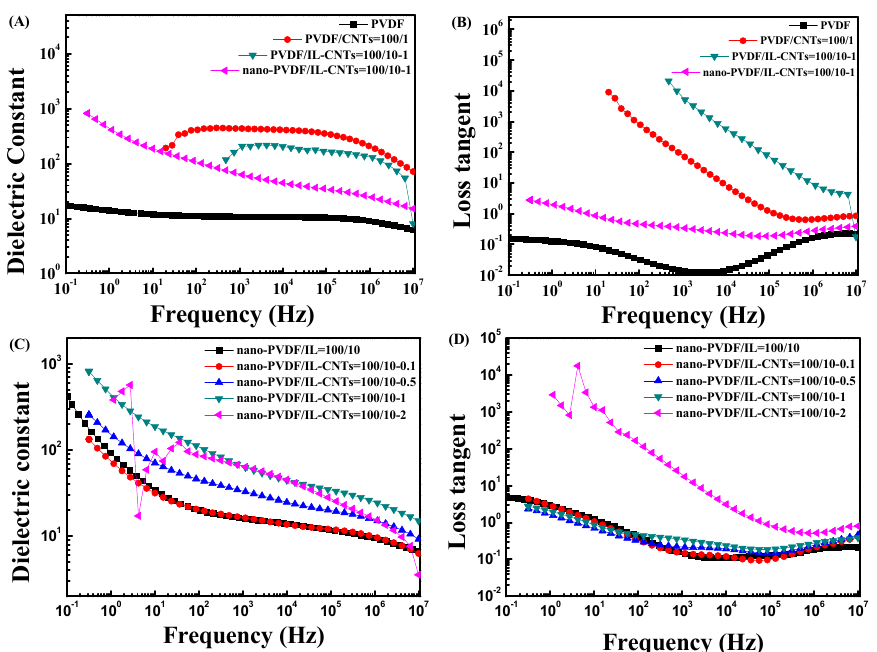
Figure 7. Frequency dependency of dielectric constant ( A ) and ( C ) and loss tangent ( B ) and ( D ) of samples including neat PVDF, PVDF/CNTs (100/1), PVDF/IL-CNTs (100/10-1), as-irradiated PVDF/IL-CNTs (100/10-1) and nano-PVDF/IL-CNTs with various CNTs contents.